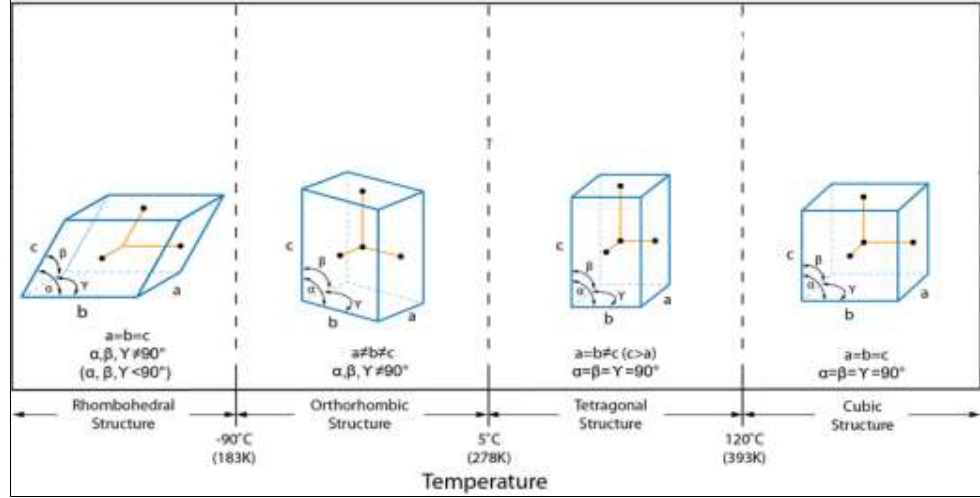
Figure 3: Phase transformations of pure BaTiO 3 vs. Temperatures